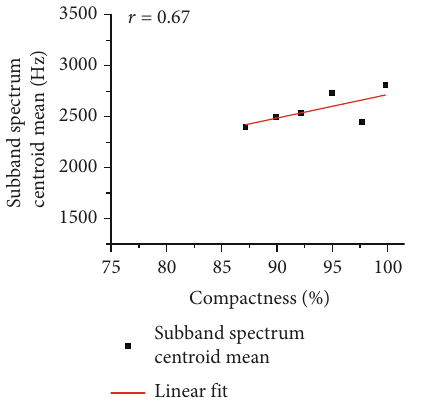
Figure 20: Correlation diagram of the mean value of the centroid of the subband spectrum and the soil mass with di ff erent compaction degrees under the action of 85(L) N hammering